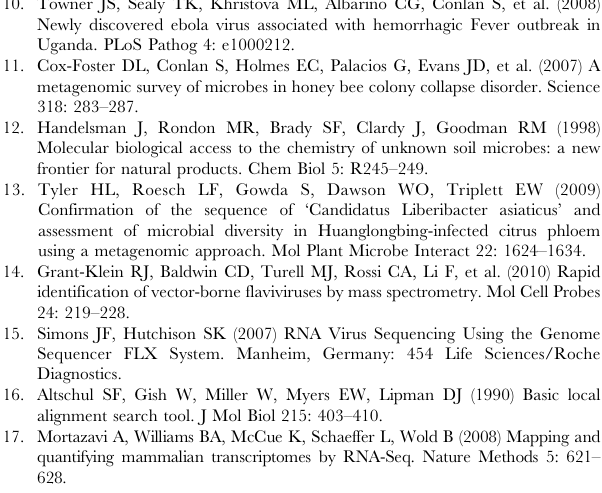
Table S1 Top 100 transcripts detected from sequencing each of the 3 mosquito libraries are listed and are ranked by relative expression levels. Table S2 Expression values and other characteristics, such as length and uniqueness, of transcripts detected from sequencing N2173 library (5 DENV-1 infected mosquitoes) are listed. Table S3 Expression values and other characteristics, such as length and uniqueness, of transcripts detected from sequencing N2175 library (1 DENV-1 infected mosquito amongst 4 noninfected control mosquitoes) are listed. Table S4 Expression values and other characteristics, such as length and uniqueness, of transcripts detected from sequencing N2187 library (5 noninfected control mosquitoes) are listed.